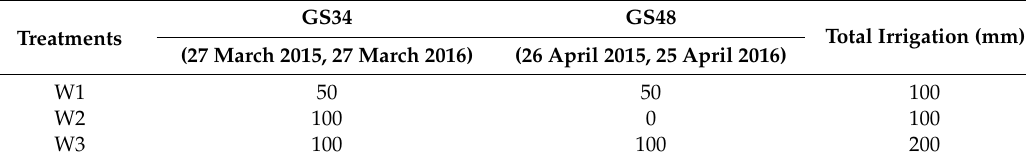
Table 2. The amount and time of irrigation during the growing season of winter wheat in 2014–2016.